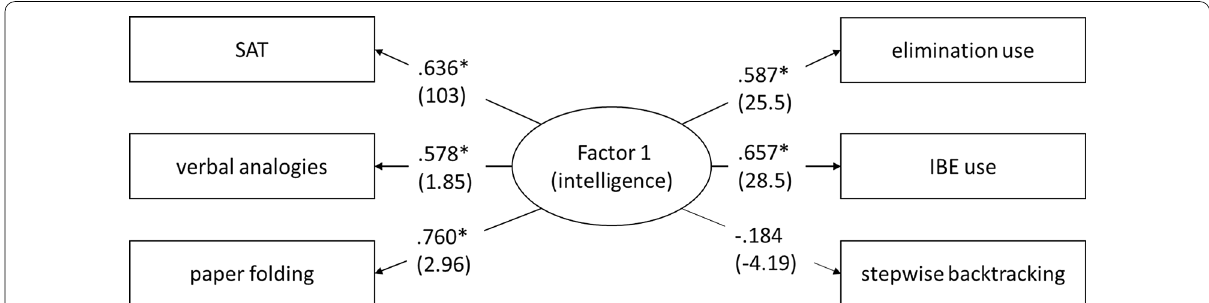
Fig. 5 Structural Equation Model of the effect of intelligence on causal inferences. Fit was very good, X 2 (6) RMSEA 0.088. Covariances among the dependent variable error terms are omitted for clarity (See Table 11). Standardized solution (unstandardized = coefficients in parentheses), N 105. * p < 0.05 =